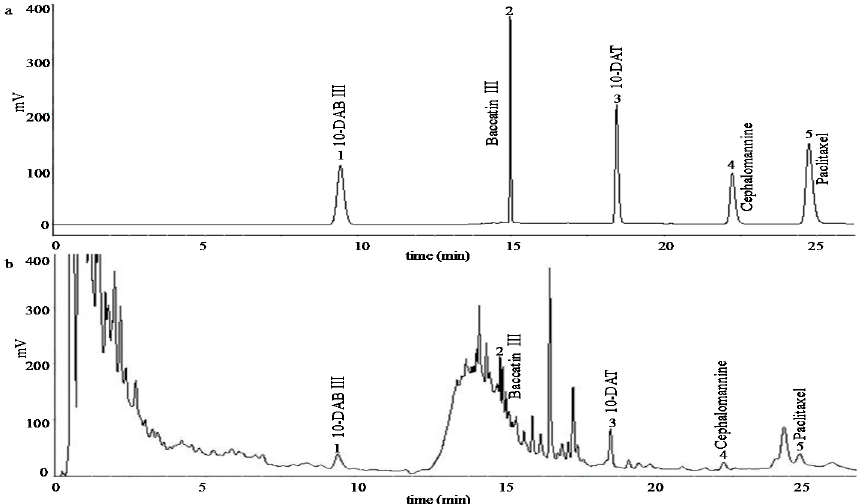
Figure 6. UPLC chromatogram of the five taxoids. ( a ): standard chromatogram; and ( b ): samples chromatogram. Chromatogram conditions were given in Section 3.4.1.